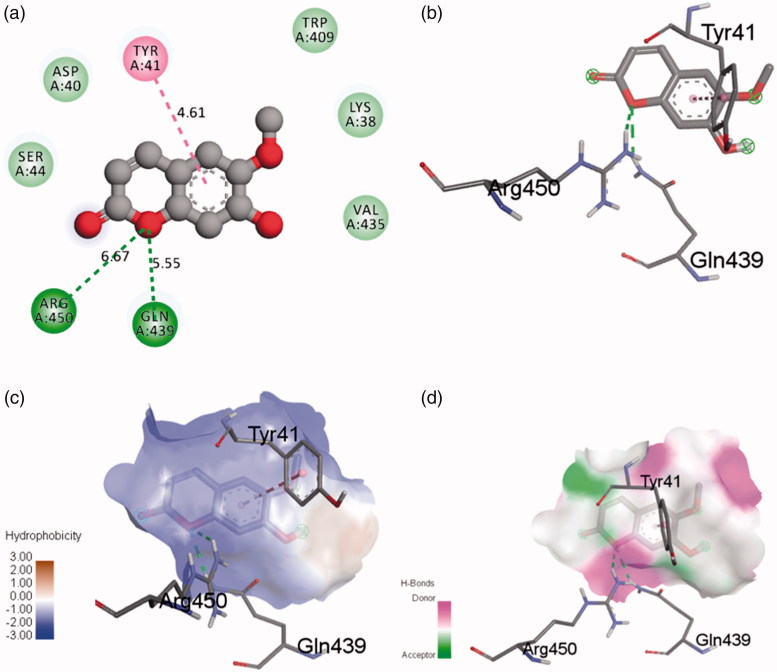
Binding of scopoletin to α-glucosidase pocket. (a) 2D-diagram of ligand interaction. (b) receptor–ligand interaction. (c) Hydrophobic surface. (d) Hydrogen bond surface.